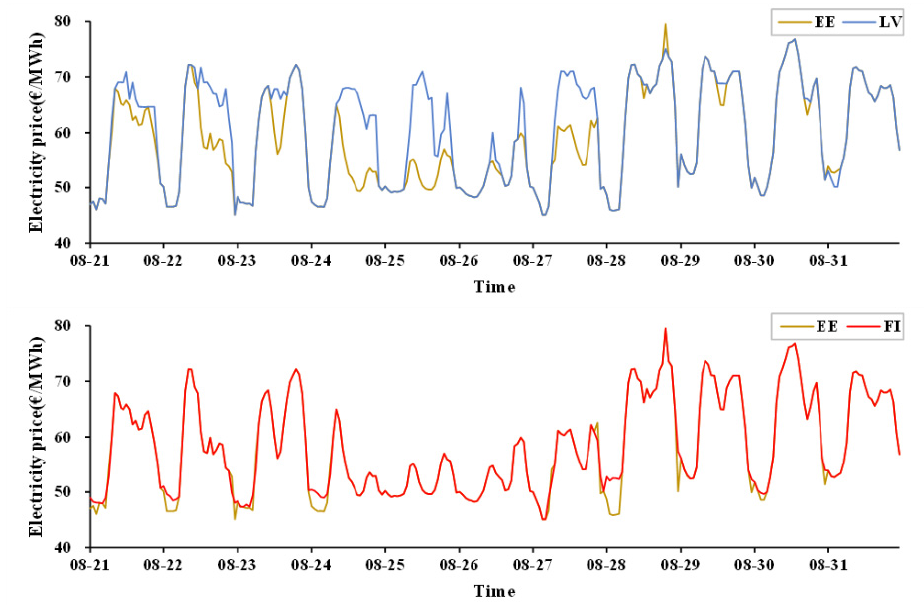
Figure 12. Electricity price data for the three areas, EE, LV, and FI.